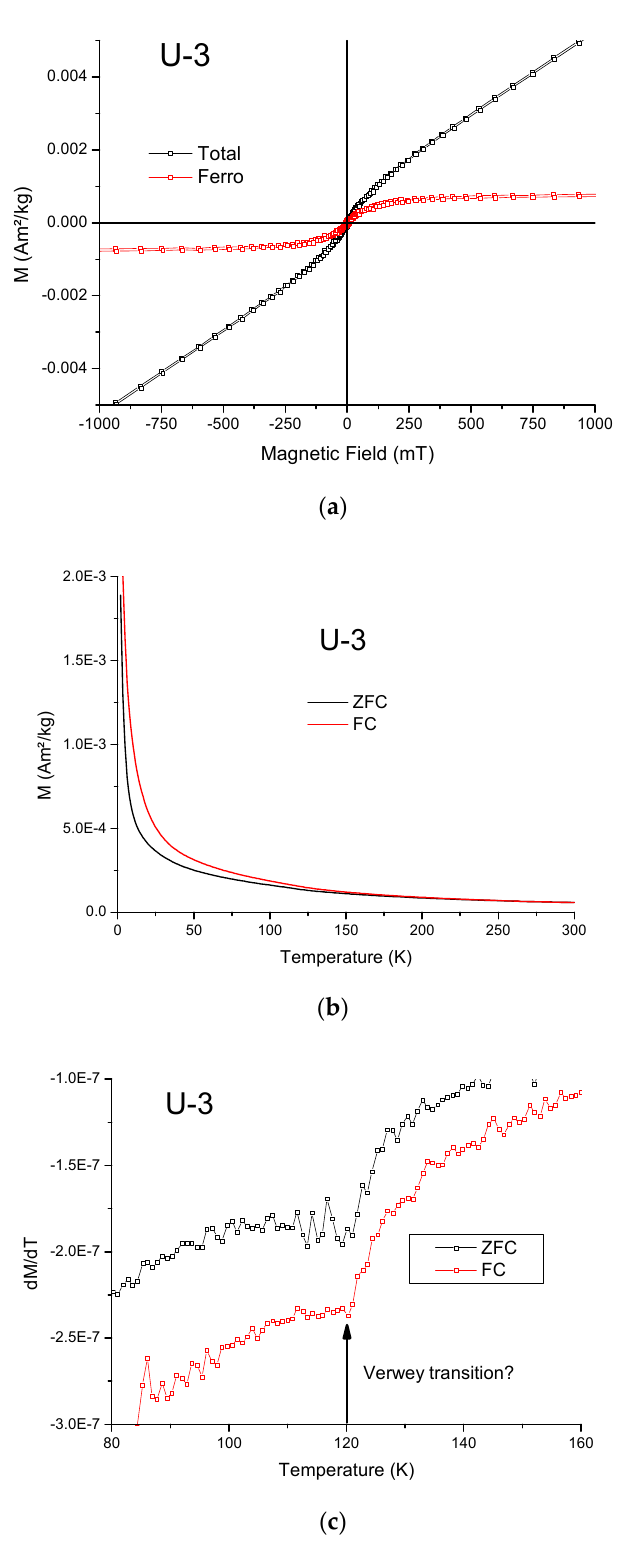
Figure 10. ( a ) Room temperature hysteresis for urengoite U3; ( b ) low-temperature remanence heating Figure 10. a ) Room temperature hysteresis for urengoite U3; b ) low-temperature remanence heating curves; ( c ) remanence derivative from ( b ) showing probable Verwey transition of curves; c ) remanence derivative from b) showing probable Verwey transition of magnetite.